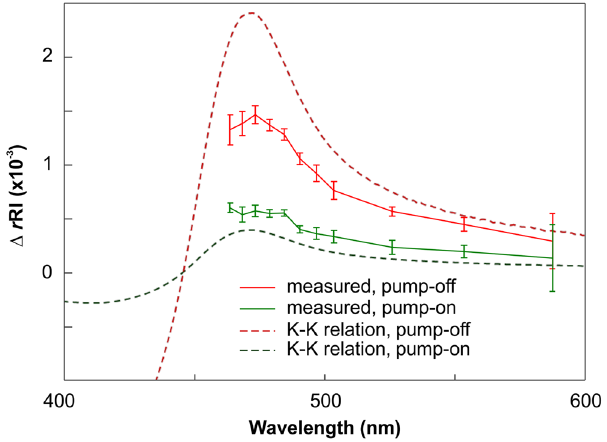
Figure 3. Comparison between calculated Δ r RI trends of the PYP based on the K–K relations (dotted lines) and measurements (solid lines). The solid lines are identical to the inset in Fig. 2b. The red and green curves indicate the case in the absence (pump-off) and the presence (pump-on) of the pump beam, respectively. The y -axis offset of the dotted lines is set discretionarily because of the ambiguity arising from the integral forms of the K–K